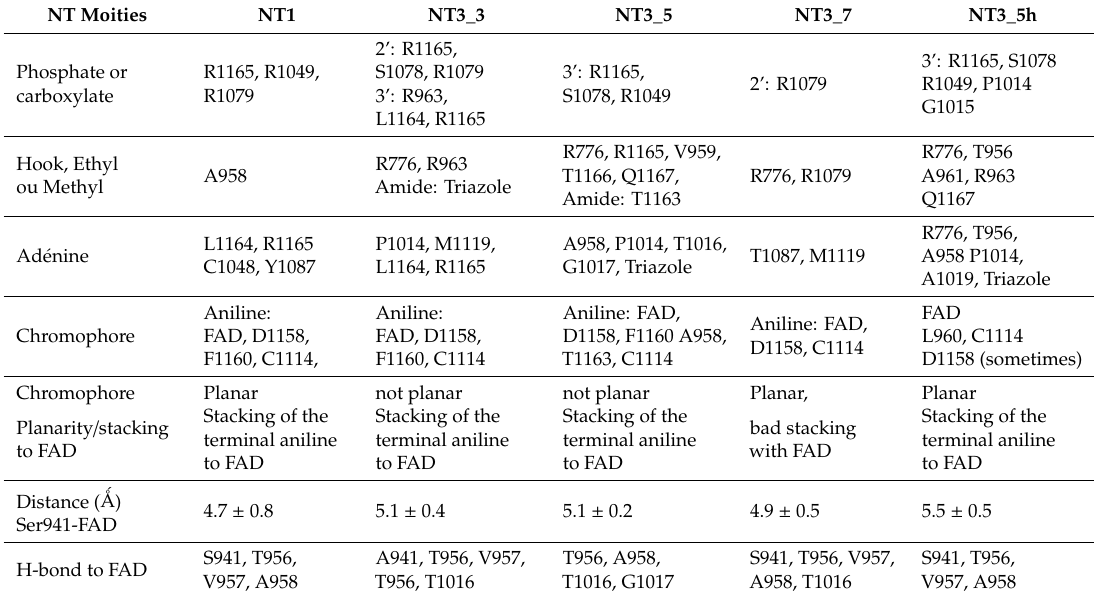
Table 2. Main interactions of the NTs in their binding pocket in eNOS reductase domain.